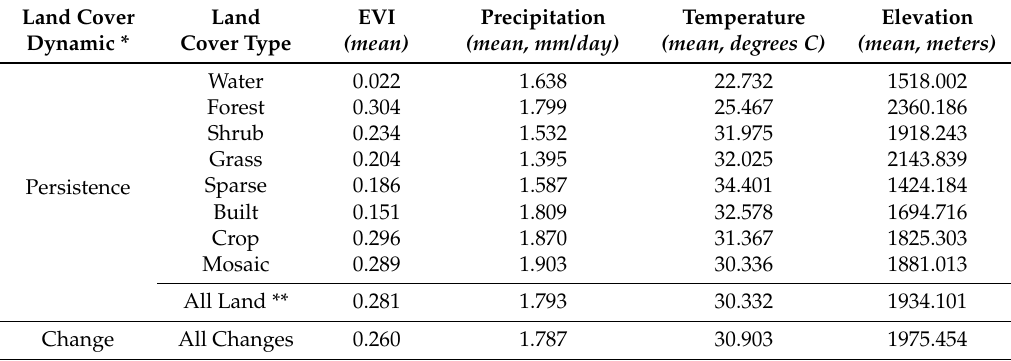
Table 2. Summary statistics of average EVI, temperature, and precipitation by land cover type and dynamics, 2001–2007.